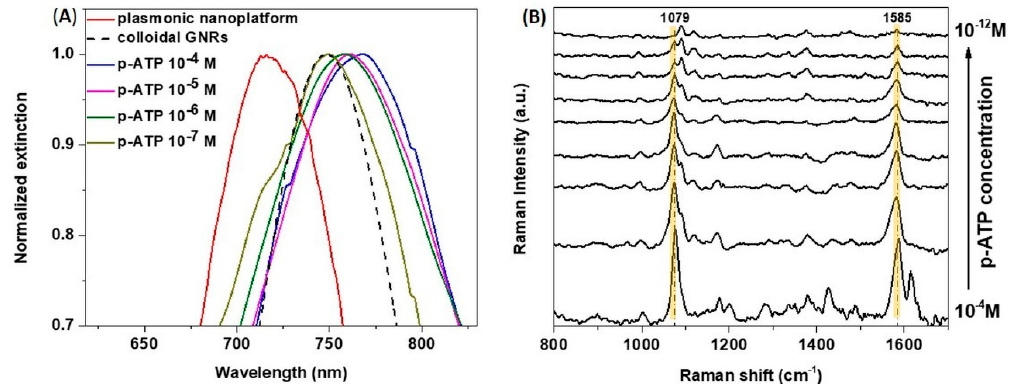
Figure 5. ( A ) Comparison between the position of the longitudinal LSPR bands corresponding to pure plasmonic nanoplatforms before and after adding different concentration of p-ATP molecules; ( B ) SERS spectra of the plasmonic nanoplatforms recorded at varying p-ATP concentration; excitation laser line used: 785 nm.